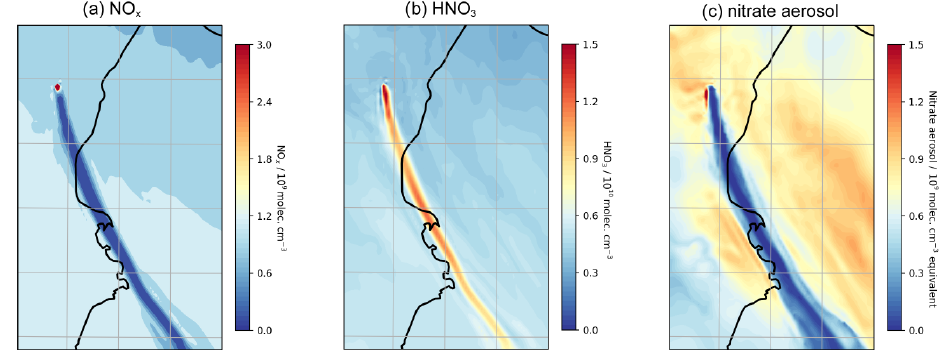
Figure 17. (a) Model mixing ratio of NO x , (b) model mixing ratio of HNO 3 , (c) equivalent mixing ratio of aerosol-phase nitrate at 3300ma.s.l. in the model at 08:00UTC on 1 August